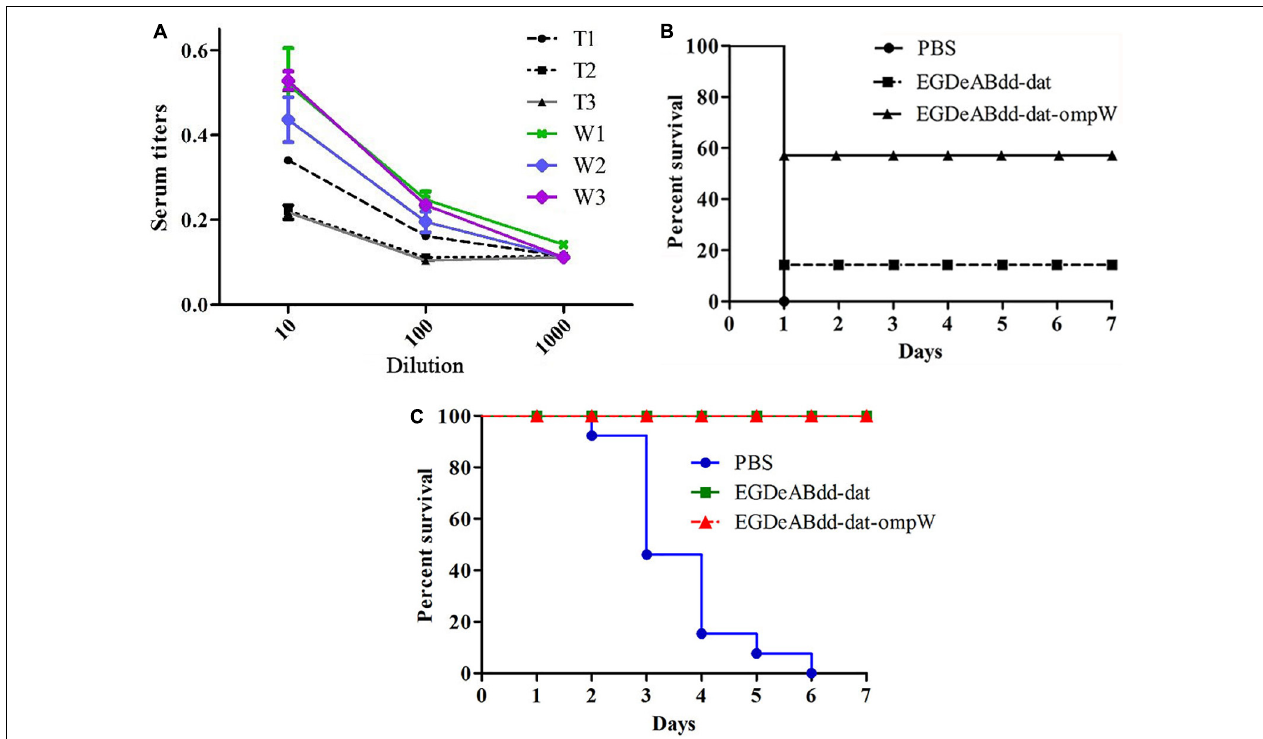
FIGURE 11 | Analysis of humoral immune response and immunoprotective effect. (A) Serum titers of mice against Aeromonas hydrophila (AH) immunized with EGDeABdd-dat and EGDeABdd-dat-ompW . T1–T3, mice immunized with EGDeABdd-dat for four times using a dose of 5 × 10 7 colony-forming units (CFUs), and the immune interval was 1 week. W1–W3, mice immunized with EGDeABdd-dat-ompW for four times using a dose of 5 × 10 7 CFUs, and the interval was 1 week. (B) Immunoprotective effect of phosphate-buffered saline (PBS), EGDeABdd-dat , and EGDeABdd-dat-ompW groups to AH. One week after the fourth immunization, serum collection and challenge were performed. The mice in PBS, EGDeABdd-dat , and EGDeABdd-dat-ompW groups were challenged with AH of 2 × 10 6 CFUs. (C) Mice were challenged with Listeria monocytogenes (LM) EGDe using a dose of 2 × 10 7 CFUs. The EGDeABdd-dat and EGDeABdd-dat-ompW groups could provide a 100% protective